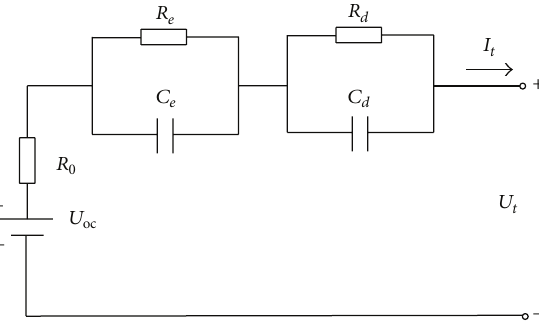
Figure 1: Equivalent circuit of second-order RC